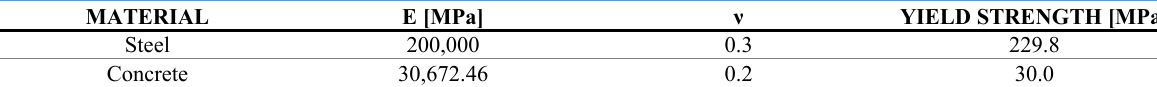
Table 2. Materials mechanical properties for parametric study.